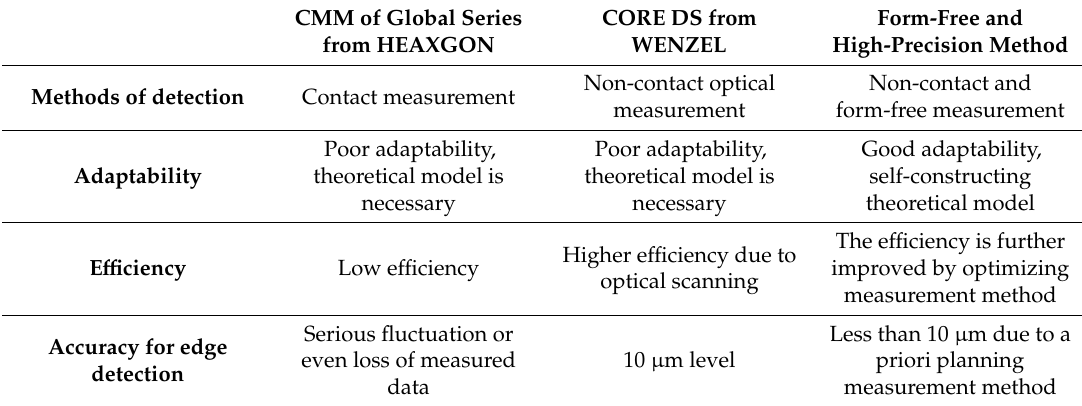
Table 5. Analysis and comparison of common methods for blade twist